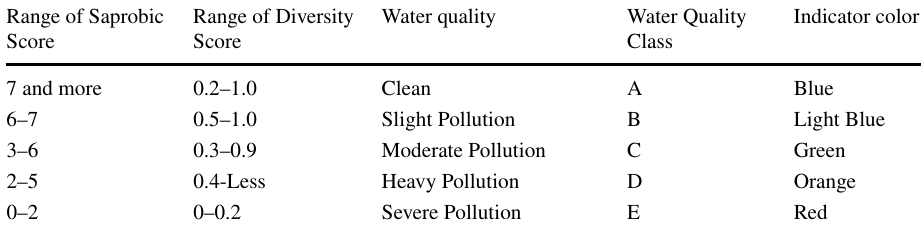
Quality Criteria (BWQC) developed by CPCB